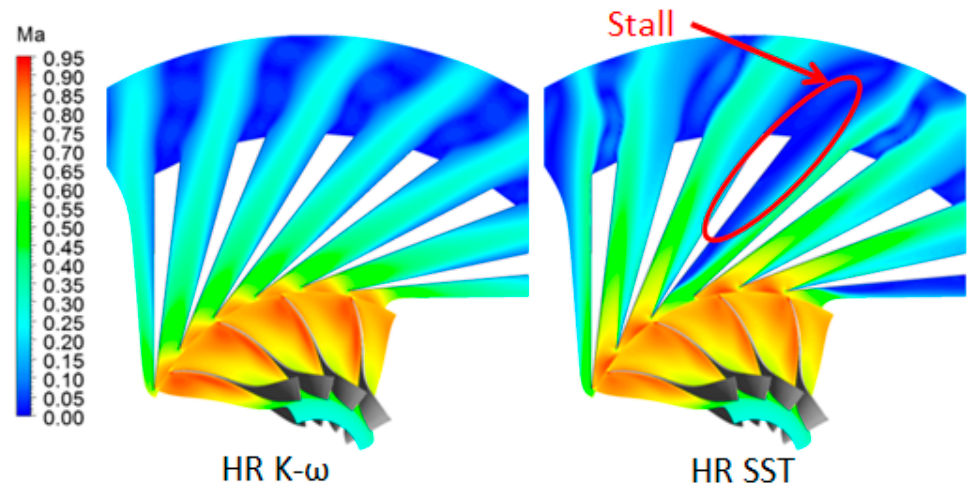
Figure 4. Mach number distribution at z/b = 0.5 for steady simulations HR k- ω (left) and HR-SST (right) in the operating point P1.